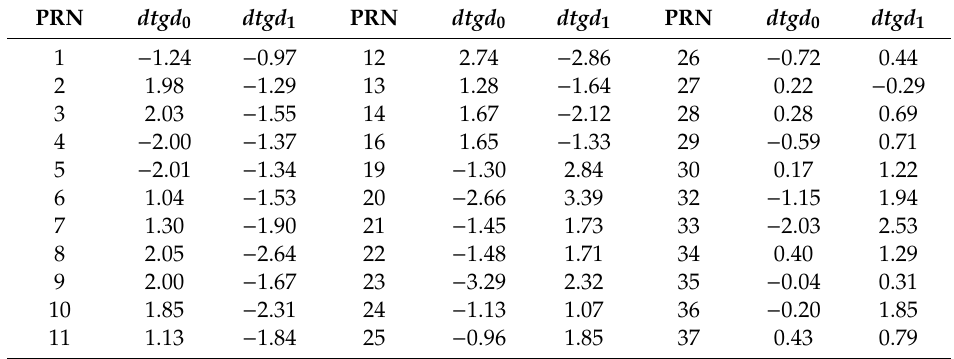
Table 3. TGD bias of BDS-2 and BDS-3 (in ns).